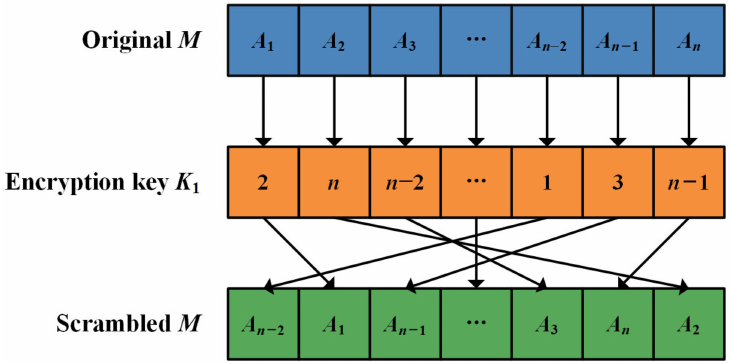
Figure 4. Scrambling